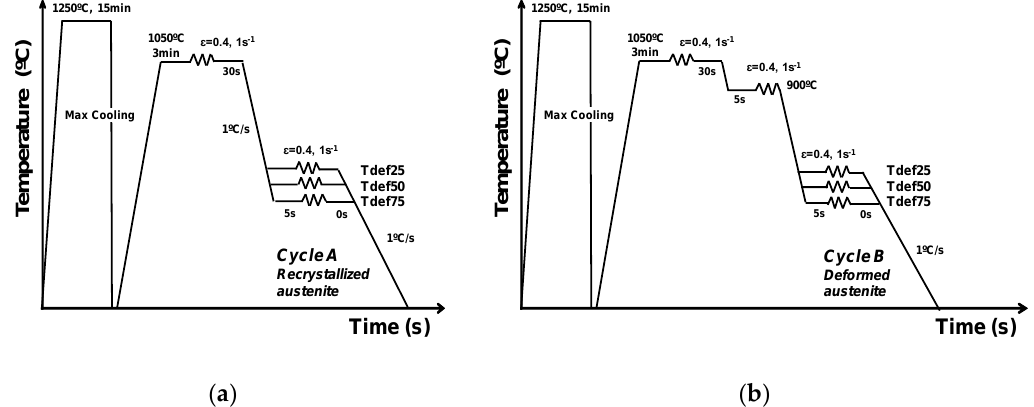
Figure 1. Thermomechanical schedule performed in the dilatometer: ( a ) CMn steel and NbV-microalloyed steel; ( b ) NbV-microalloyed steel only.